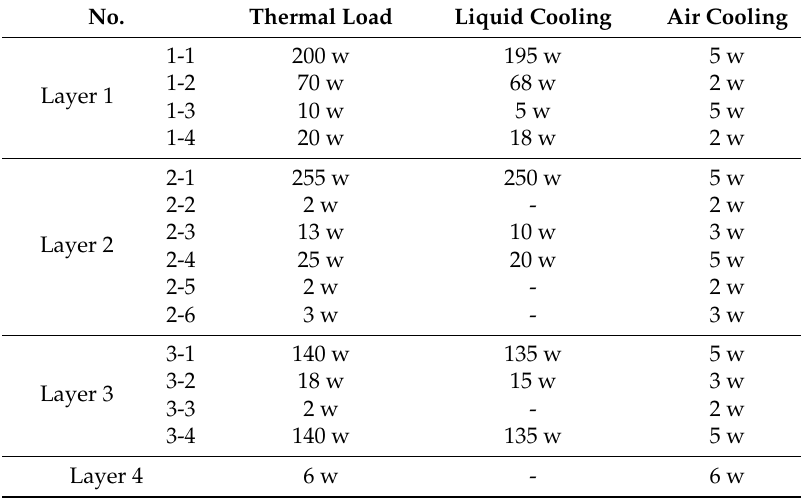
Table 1. Parameters of heat